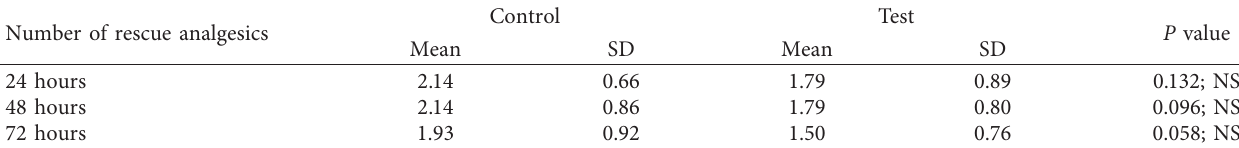
Table 2: Comparison of the mean number of rescue analgesics between test and control interventions. Number of rescue